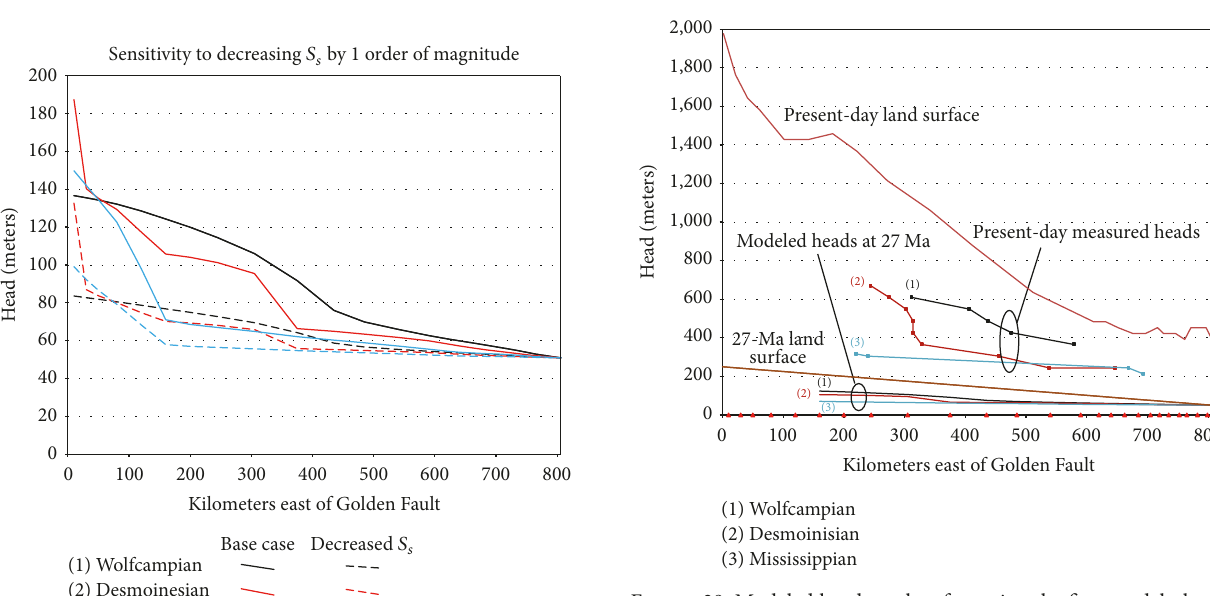
Figure 25: Sensitivity to increasing 𝑆 𝑠 by an order of magnitude.